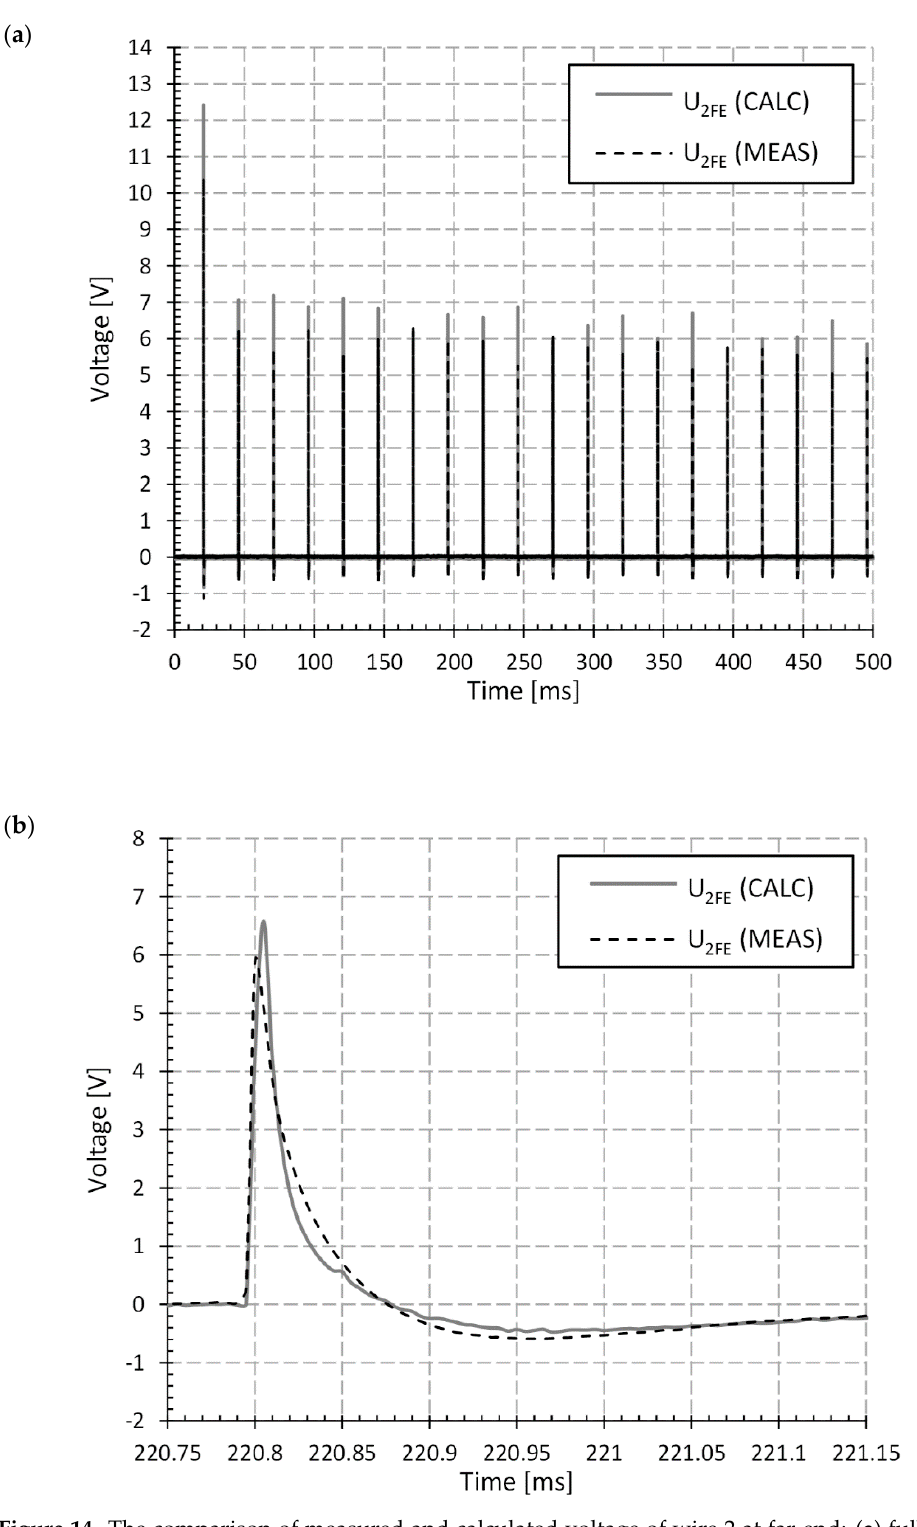
Figure 14. The comparison of measured and calculated voltage of wire 2 at far-end: ( a ) full scale view; ( b ) view of the 8th subsequent stroke.